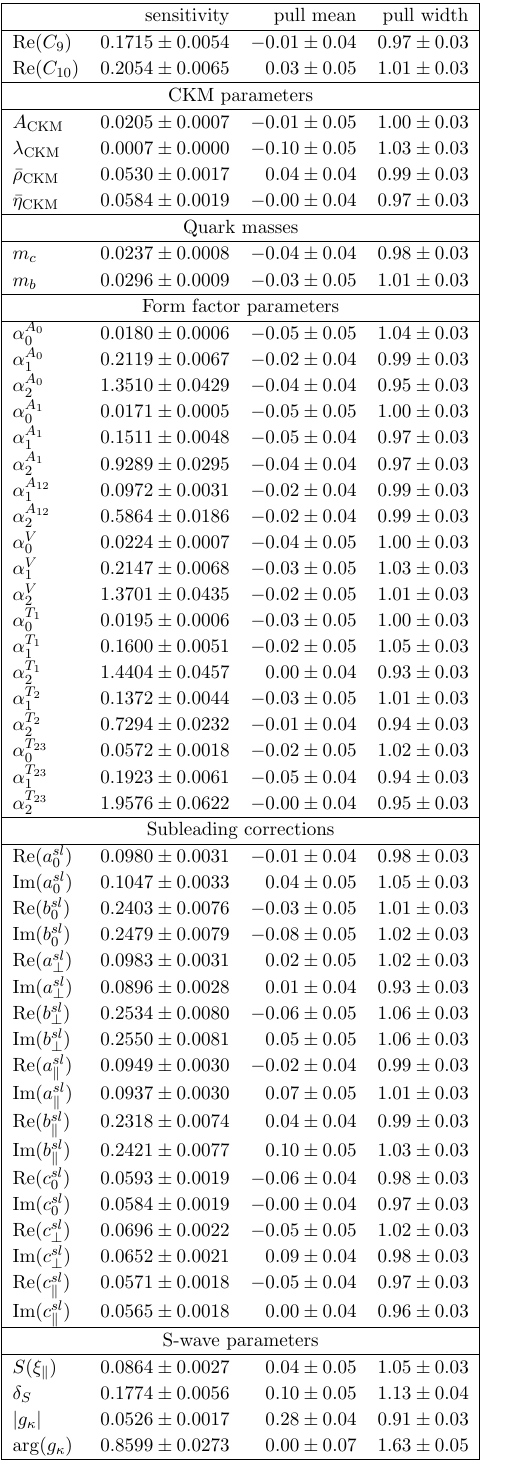
Table 9. Results from pseudoexperiments determining Re( C 9 ) and Re( C 10 ) using (left) the proposed direct (cid:12)t method and (right) the q 2 -binned approach.